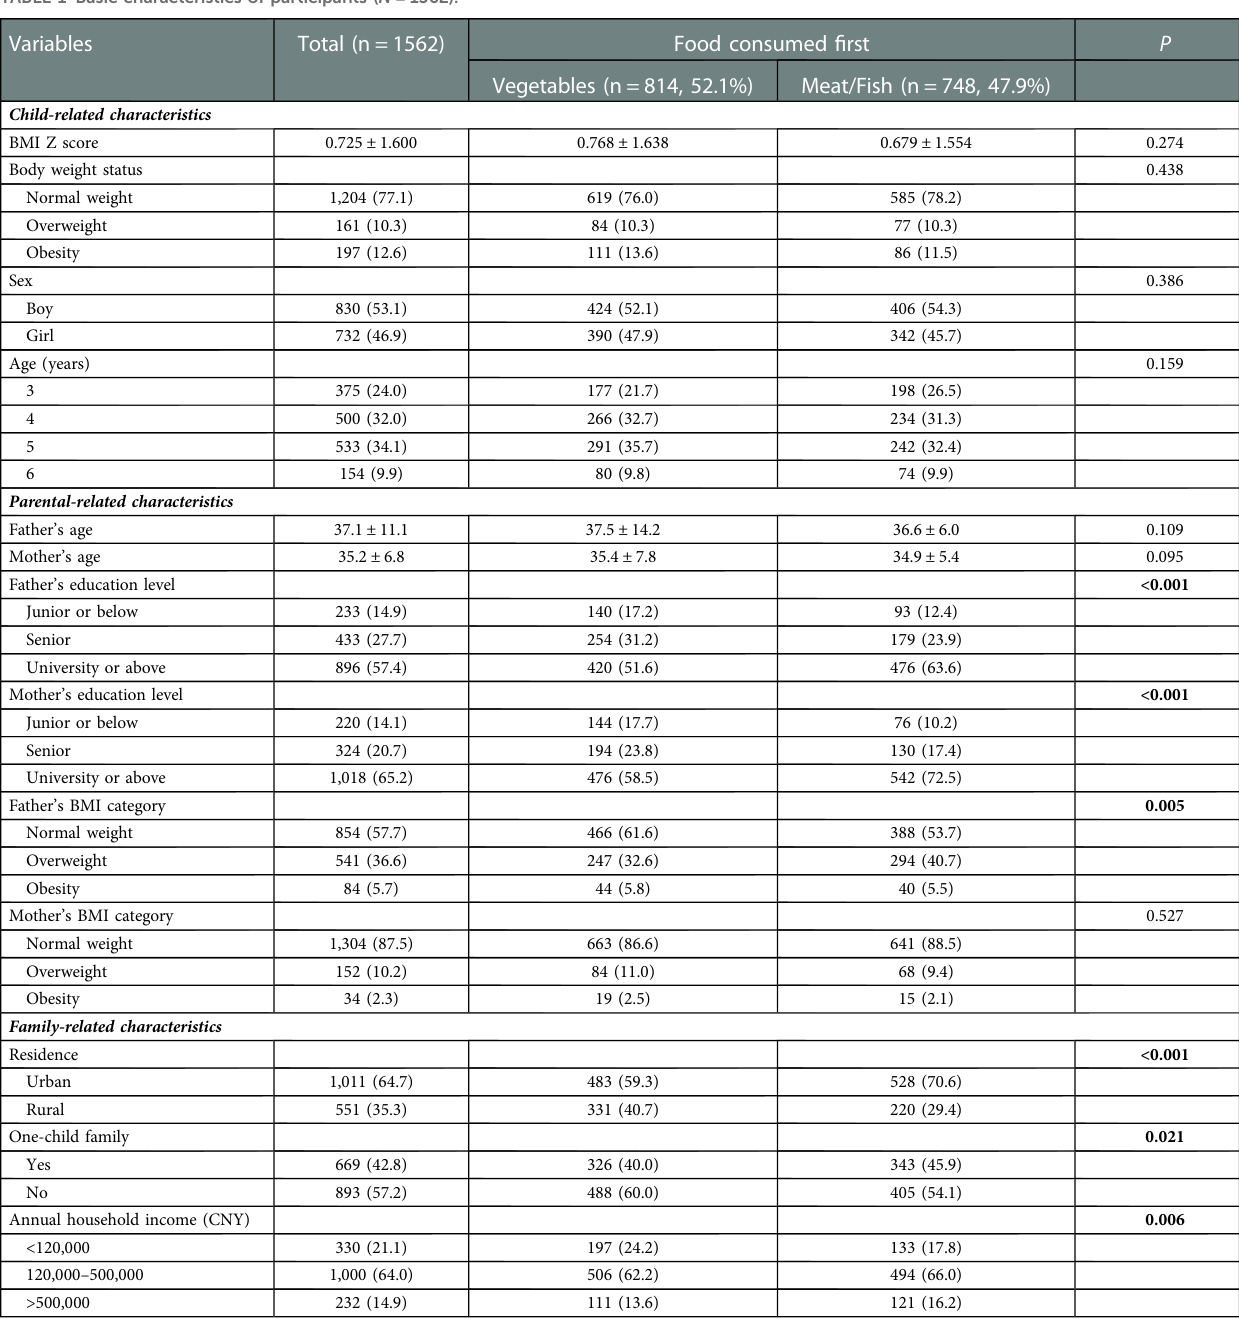
TABLE 1 Basic characteristics of participants ( N